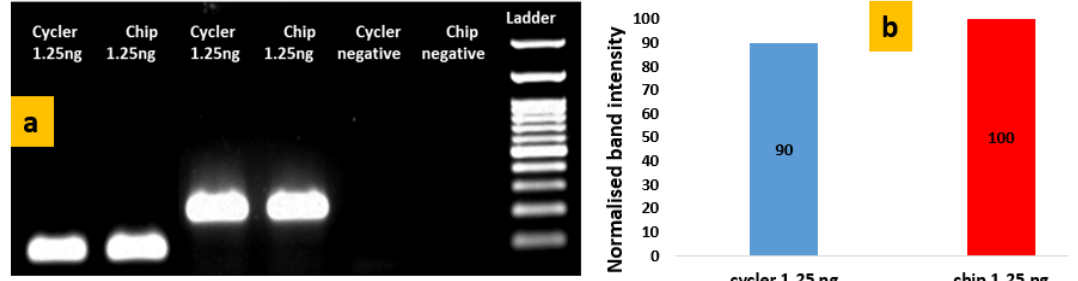
Figure 9. ( a ) Agarose gel electrophoresis image depicting the products (117 bp and 223 bp) from the conventional thermocycler and the static microPCR for purified genomic Salmonella DNA using 1.25 ng of DNA / 25 µ L PCR reaction; ( b ) comparison of normalized band intensities from the thermocycler and the chip after 40 cycles of 2T PCR for the 223 bp amplicon. Table 3. Residence time and ramping rates for the thin PCB microheater